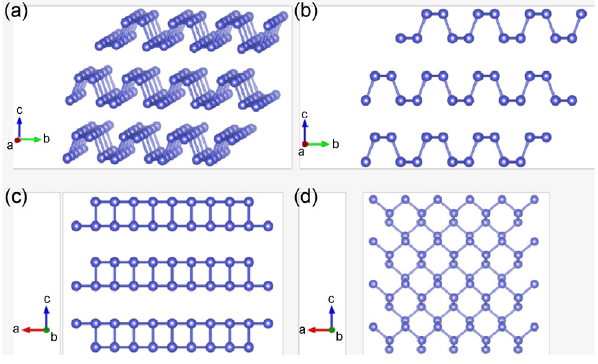
Fig. 1 Schematic diagram of the crystal structure of